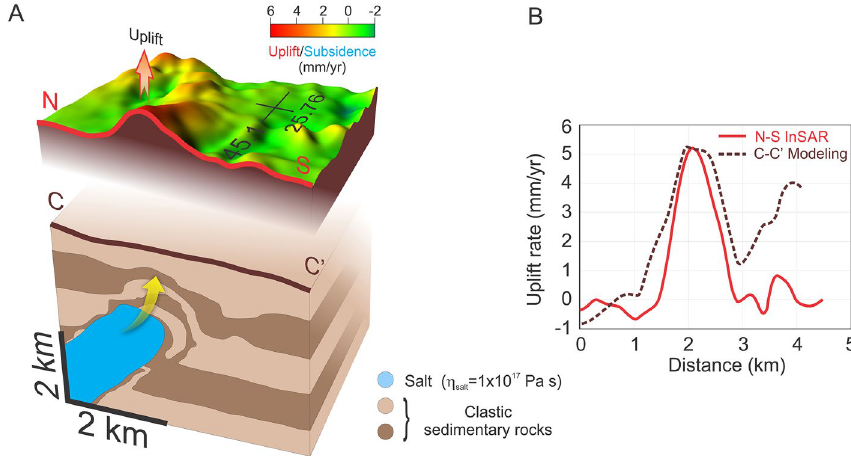
Figure 4. ( A ) Perspective image illustrating the InSAR uplift pattern (top) and the result from numerical simulation (shown in Fig. 3) where salt diapir (blue color) intrudes (yellow arrow) the overlying sedimentary rocks. 3D top map is generated with the open-source software ParaView (http:// www. parav iew. org) version 5.0.1, licensed under the CC BY 4.0 license (https:// creat iveco mmons. org/ licen ses/ by/4. 0/). ( B ) N-S cross- section of InSAR uplift rate vs. maximum surface uplift inferred from the numerical simulation where salt diapir viscosity is considered 1 × 10 17 Pa